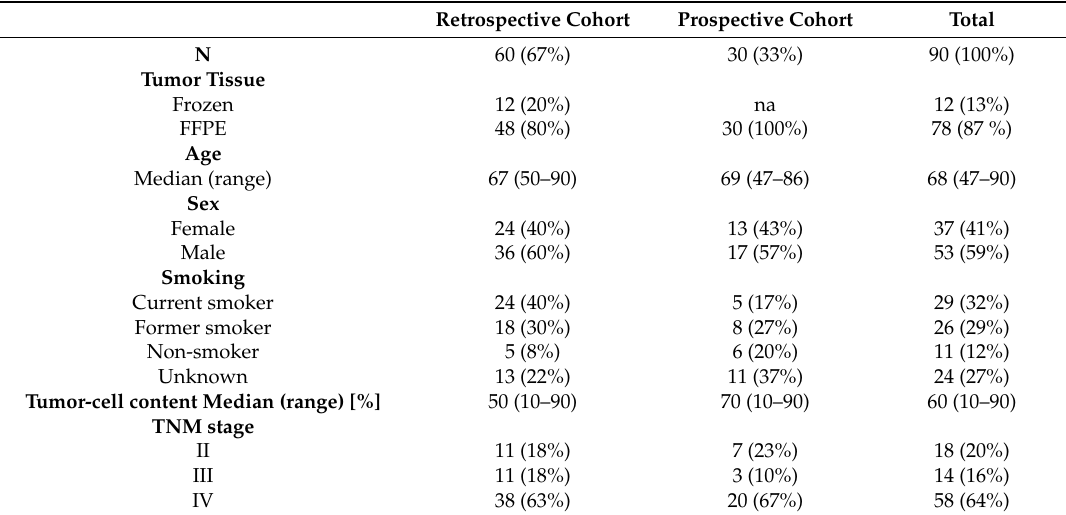
Table 3. Description of the patient